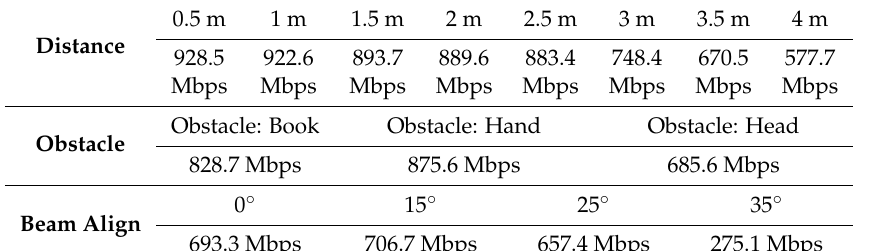
Table 2. UDP throughput vs. distance, obstacle, and misalignment of dongle USB 3.0 mmWave link.